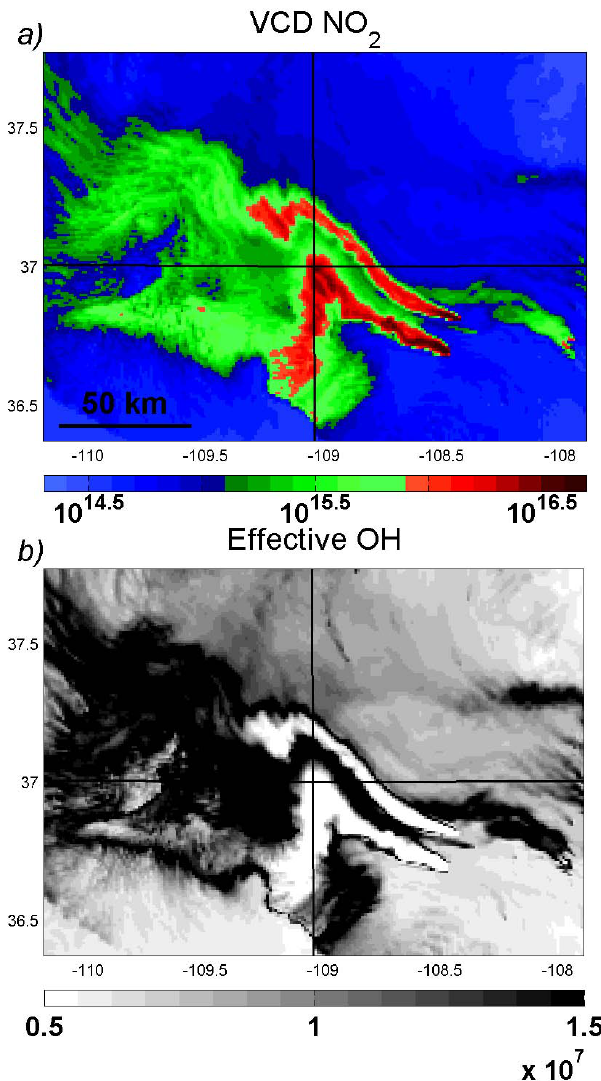
Fig. 6. (a) NO 2 column (moleculescm − 2 ) and (b) effective OH, or the NO 2 -weighted average of OH (moleculecm − 3 ), taken over the entire vertical column as simulated with WRF-CHEM at 1km resolution over the Four Corners Region of US at 10a.m. on 5 July